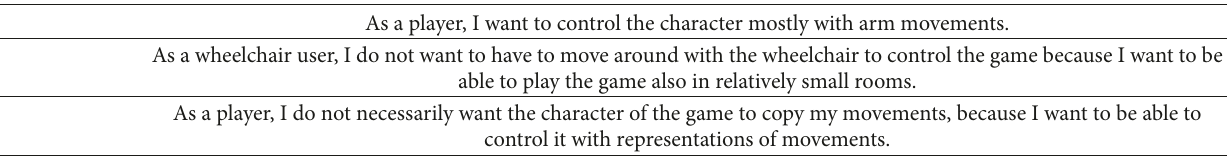
Table 5: User stories about technology collected from participants during Session 3.